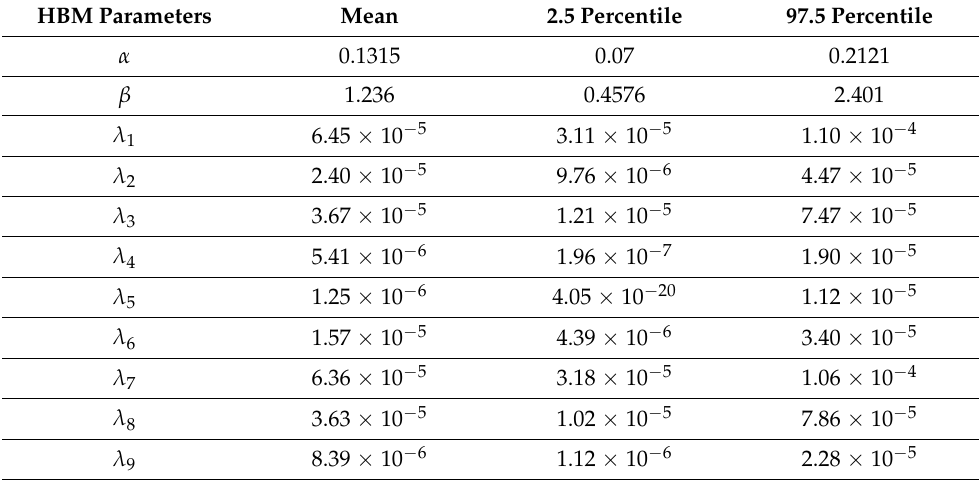
Table 2. The statistical properties of the posterior values of the hyperparameters and lambda.